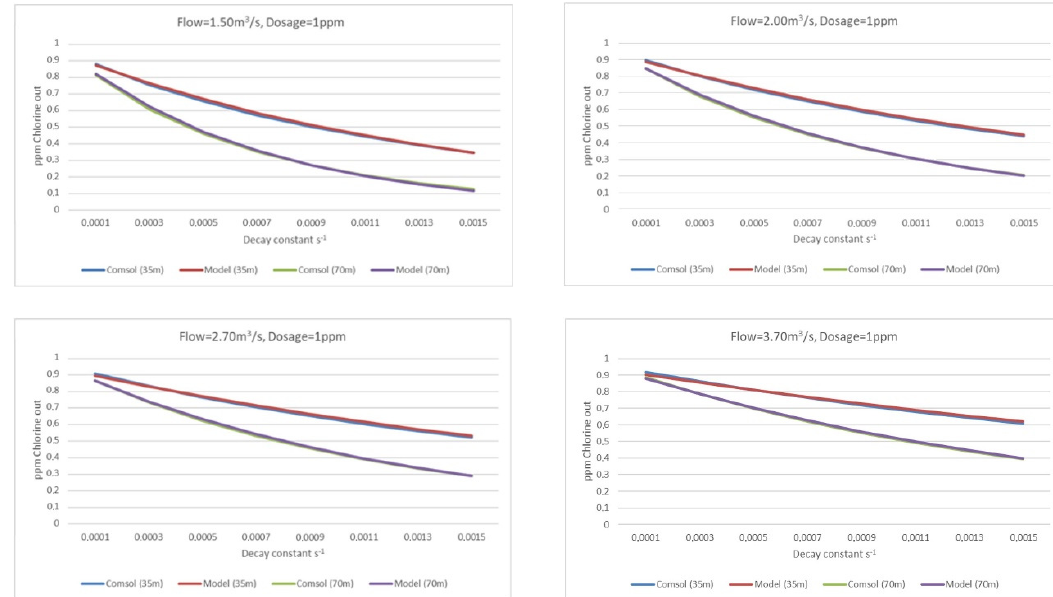
Figure 12. Results comparison between CFD Comsol data and simulator data for different flow rates (1.50, 2.00, 2.70, and 3.70 m 3 /s).